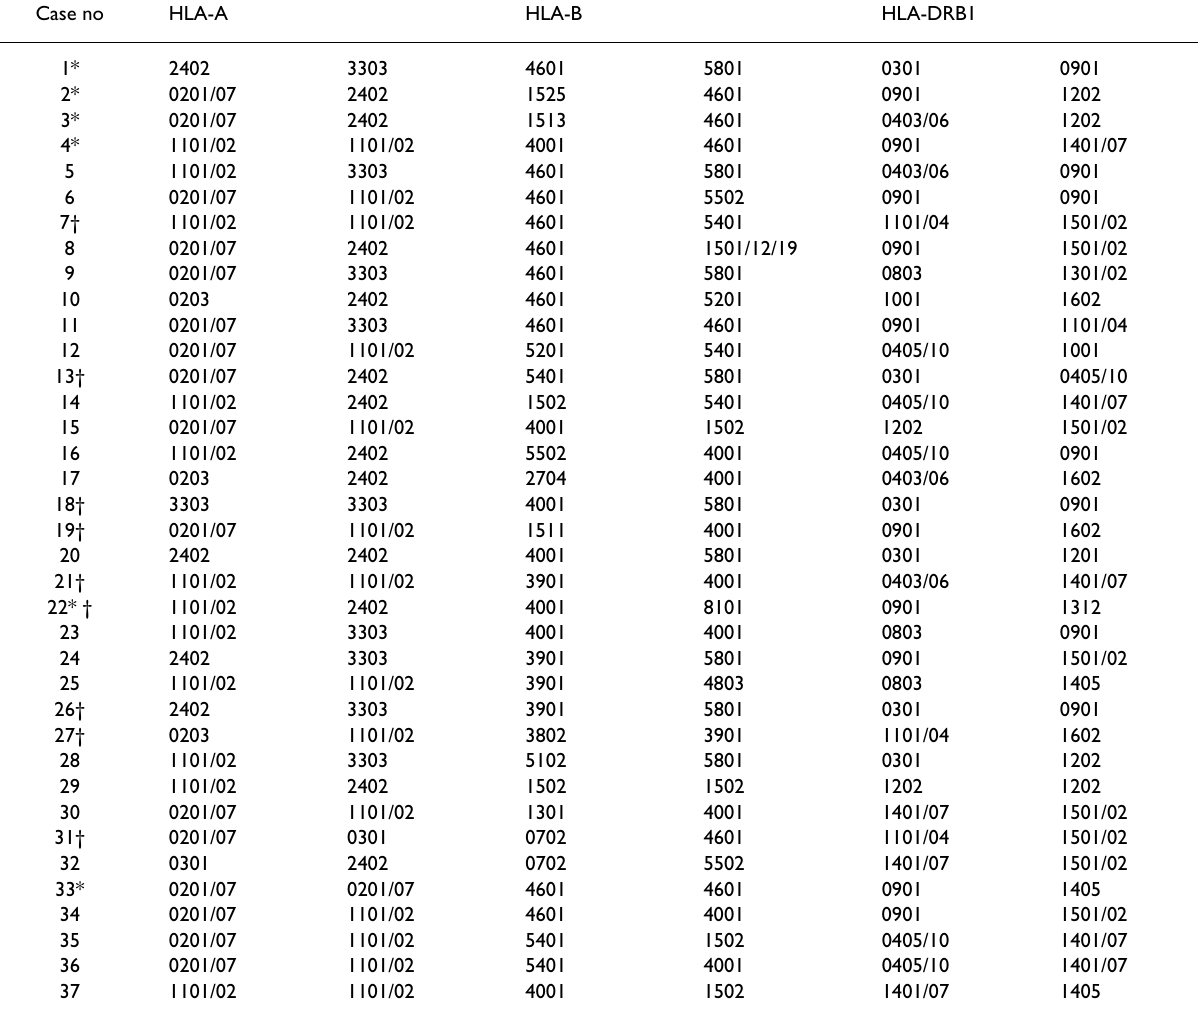
Table 1: HLA-A, B, DRB1 allele typing of 37 probable SARS